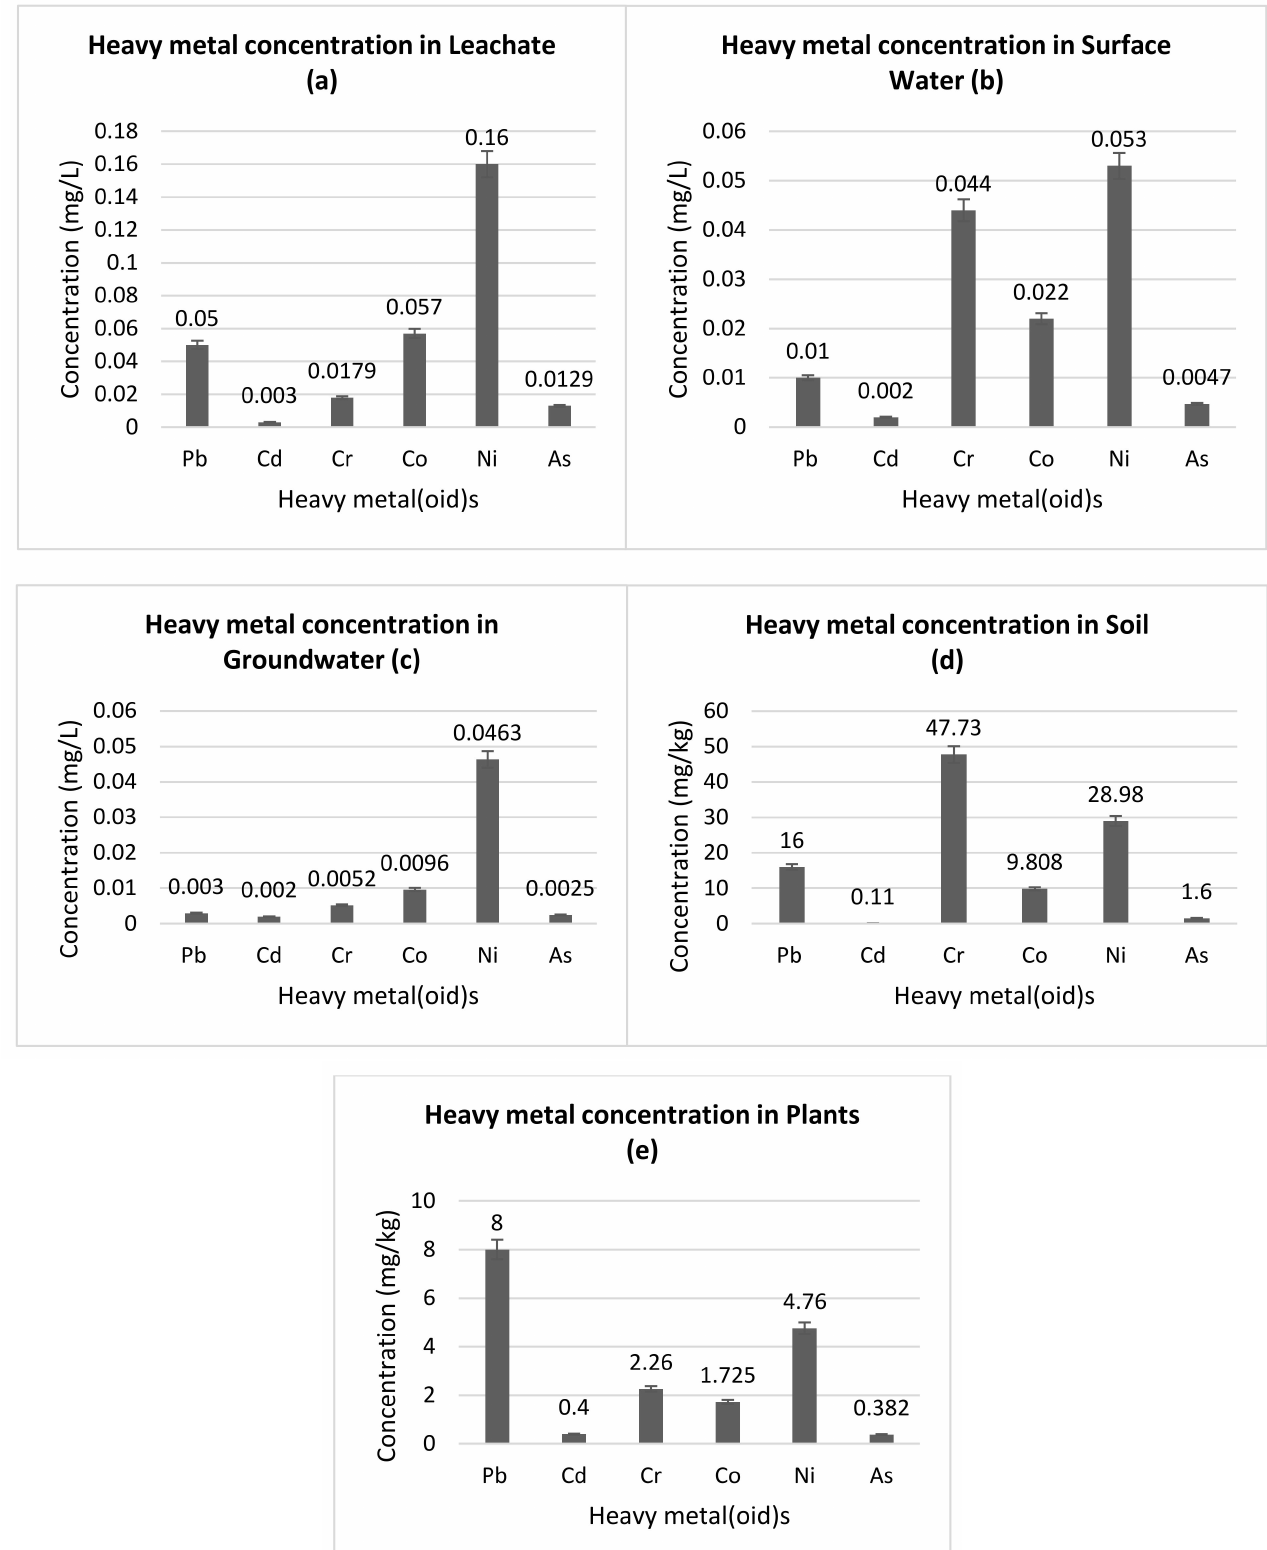
Figure 3. Heavy metal(loid)s concentration in ( a ) leachate, ( b ) surface water, ( c ) groundwater, ( d ) soil, and ( e ) plant